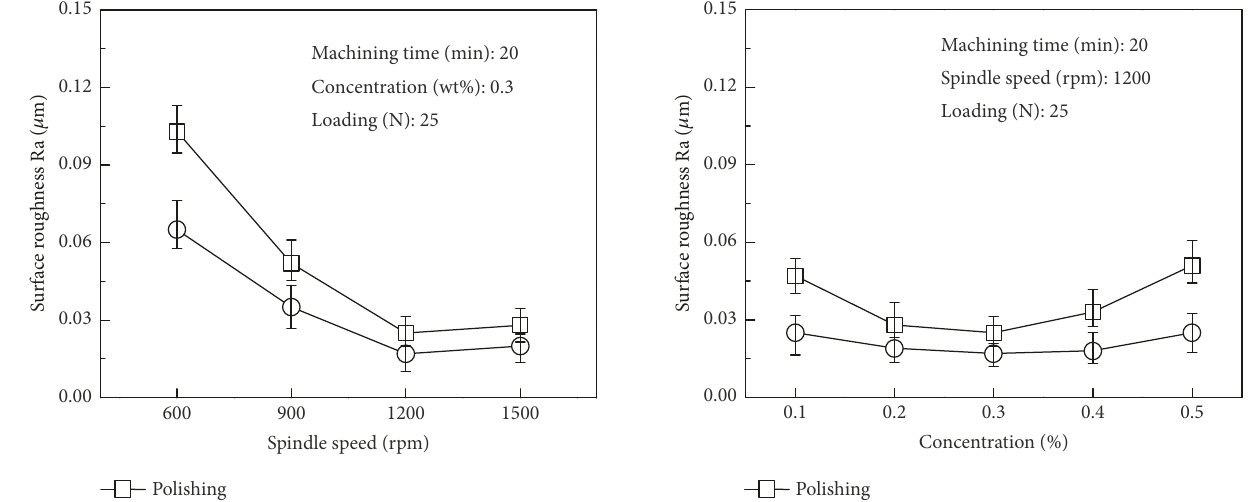
UV polishing, the ground slurry evenly flows out from the vascular bundle of bamboo charcoal, improving the surface roughness of the wafer. Nevertheless, when the spindle speed rises to 1500 rpm, abrasive grains are easily ablated due to centrifugal force; as a result, the surface roughness of the wafer does not show any significant improvement.